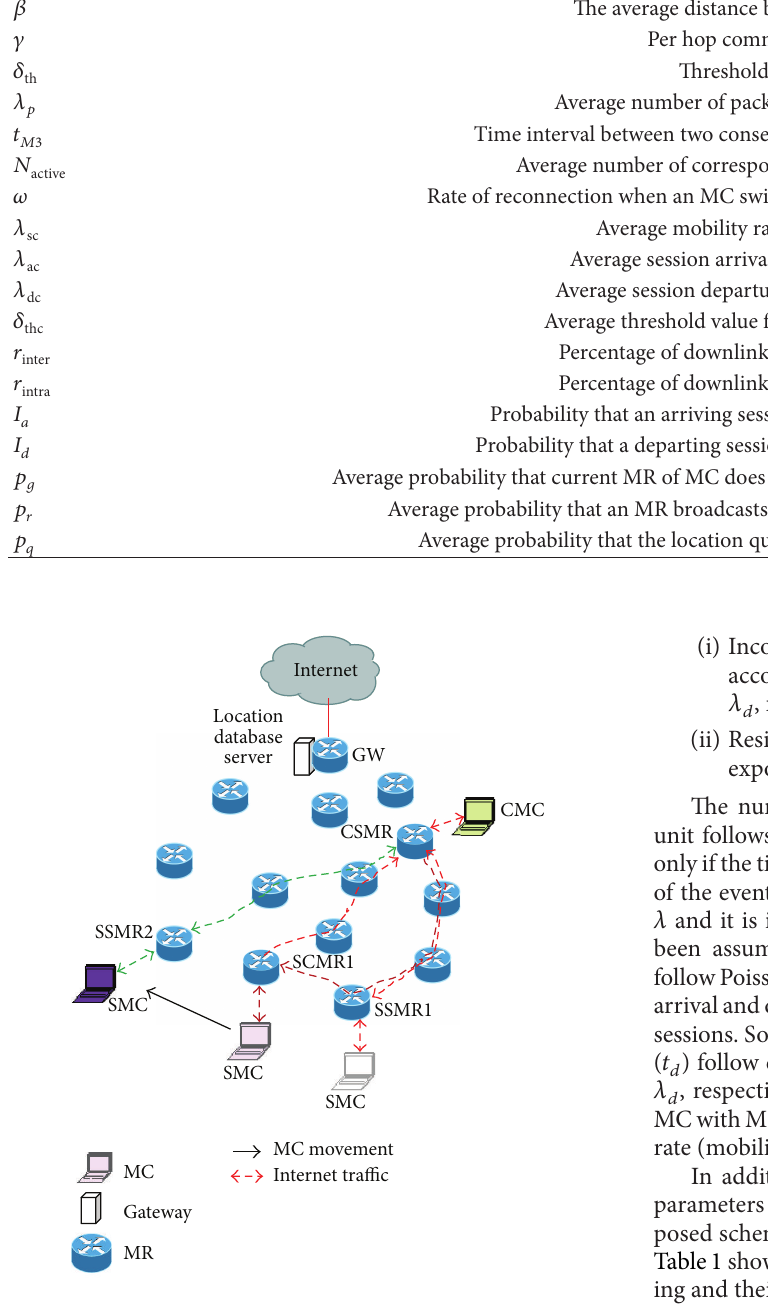
Figure 2: Routing of Intranet